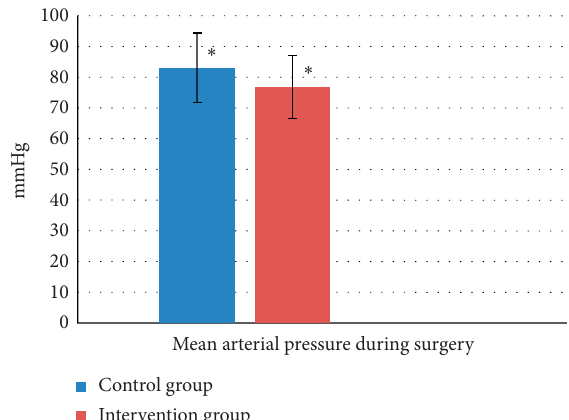
Figure 3: Mean arterial pressure during surgery in both groups during the study period. ∗ P � 0.123 and not